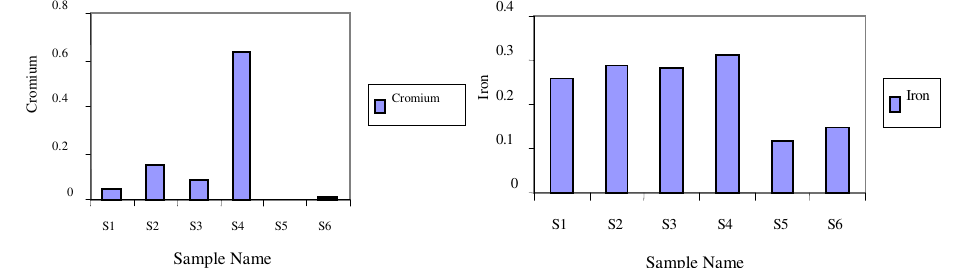
Figure 17. Cromium in various sample Figure 18. Iron in various sample